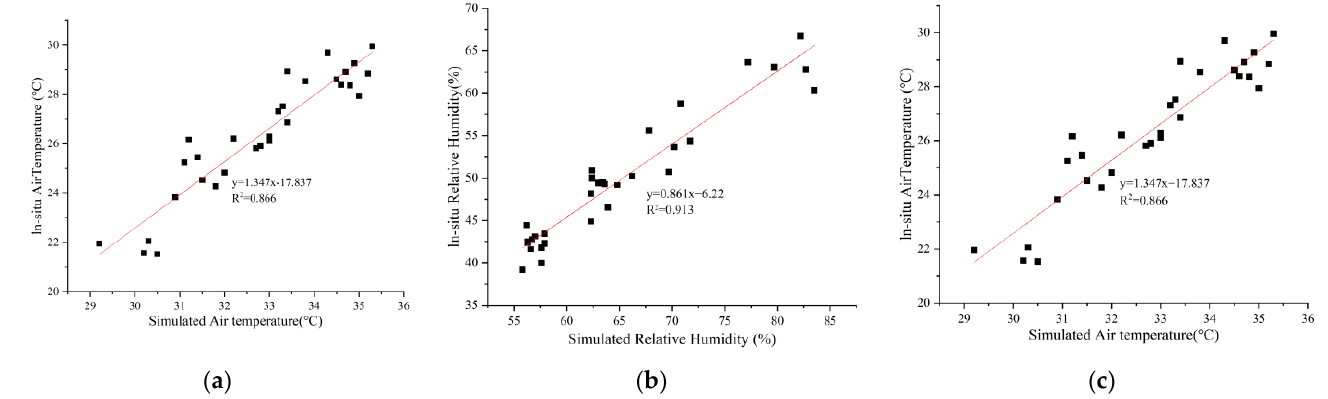
Figure 4. Correlation comparison between the measured and the simulated results: ( a ) Temperature; ( b ) Humidity; ( c ) Wind speed.